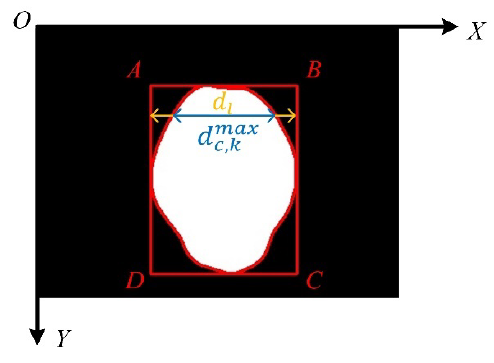
Figure 3. Schematic diagram of the calculation of the quasi-rectangularity feature.